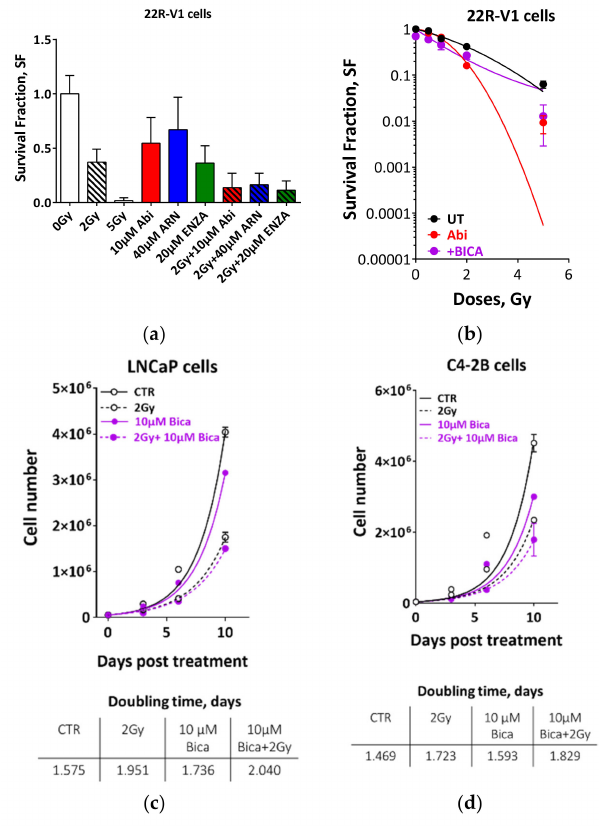
Figure 3. Second generation antiandrogen therapy but not bicalutamide potentiates the cytotoxicity of ionizing radiation in PCa cells. ( a ) 22R-V1 were treated with the indicated concentrations of second-generation antiandrognes and 2Gy either alone or combined and cell survivals were measured using colony forming assay. ( b ) 22R-V1 cells were treated with either 5 µ M abiraterone acetate or 10 µ M bicalutamide for 24 h before irradiated with the indicated doses, and the survival fractions (SFs) were measured using colony forming assay. ( c , d ) Upper panels: Cell number was determined in LNCaP ( c ) and C4-2B ( d ) cells on days 0, 3, 6 and 10 post treatment with 10 µ M bicalutamide and 2 Gy either individually or combined. Lower panels: Cell doubling time in days was calculated for each treatment by fitting exponential growth curves using GraphPad Prism 7. Shown are means ± SEM of at least three independent